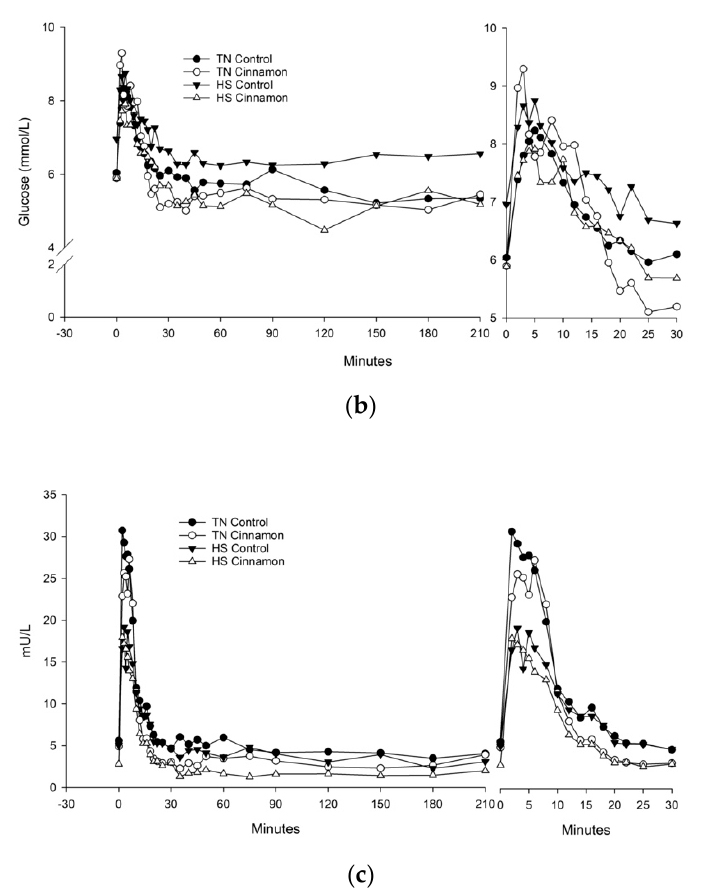
Figure 2. Concentrations of ( a ) glucose, ( b ) NEFA and ( c ) insulin following an intravenous glucose tolerance test (IVGTT) for pigs fed control or 1.5% cinnamon diets and housed under thermoneutral (TN) or heat stress (HS) conditions. On the left-hand side is the full IVGTT result used for MINMOD. On the right-hand side is a truncated view of the first 30 min of the IVGTT. The pooled SEM for glucose, NEFA and insulin were 0.835 mmol/L, 108 µmol/L and 38.1 pmol/L, respectively. The effects of diet, temperature and time were (a) p = 0.25, 0.59 and < 0.001 (b) 0.66, 0.104 and 0.063 (c) 0.23, 0.082 and <0.001.